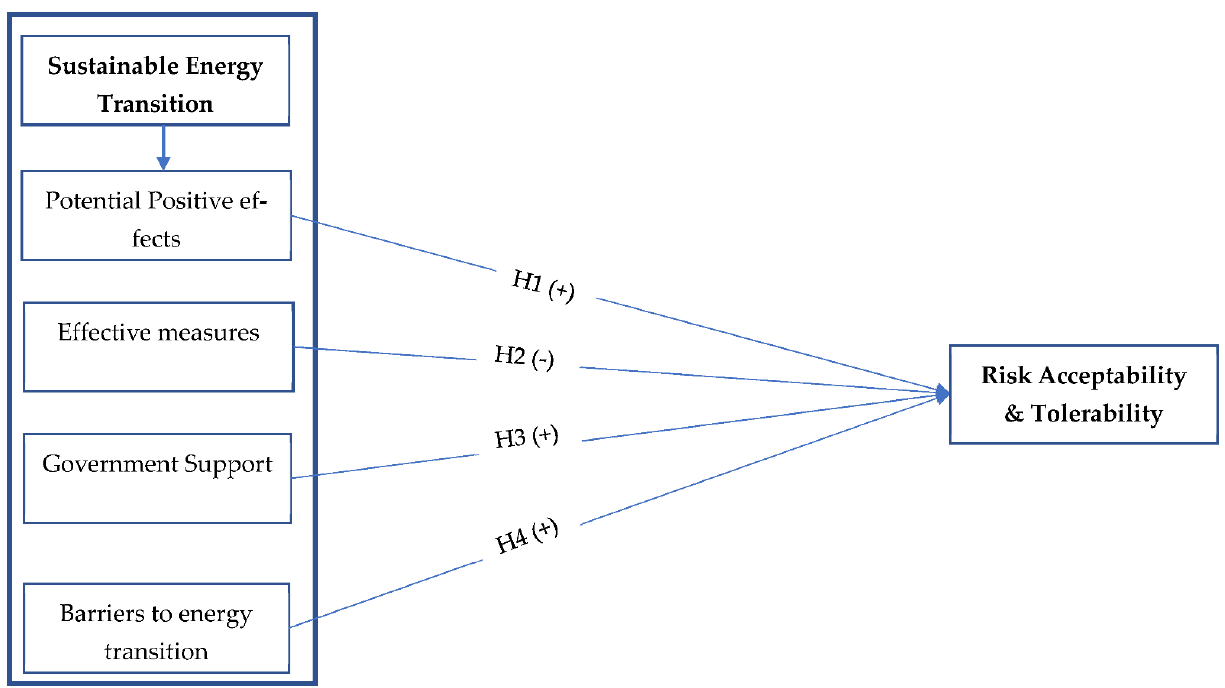
Figure 1. Research Model.